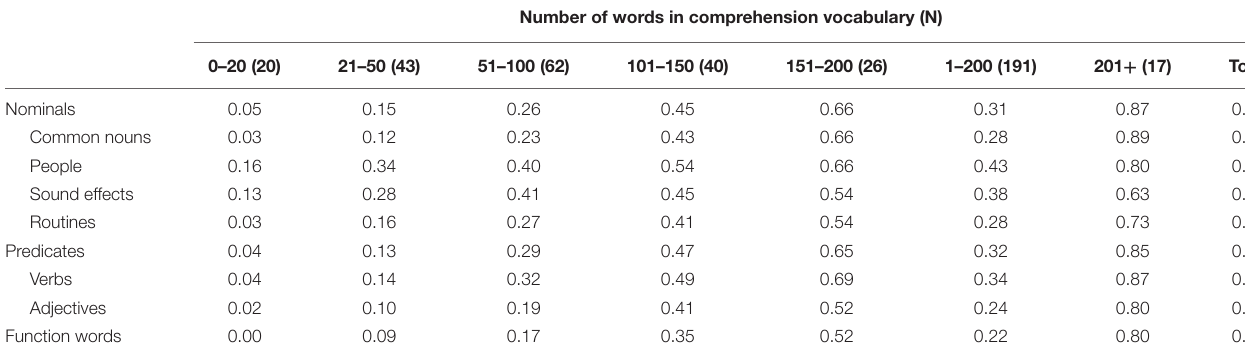
TABLE 7 | Categories of words in comprehension vocabulary at different vocabulary sizes expressed as a proportion of chances to choose each